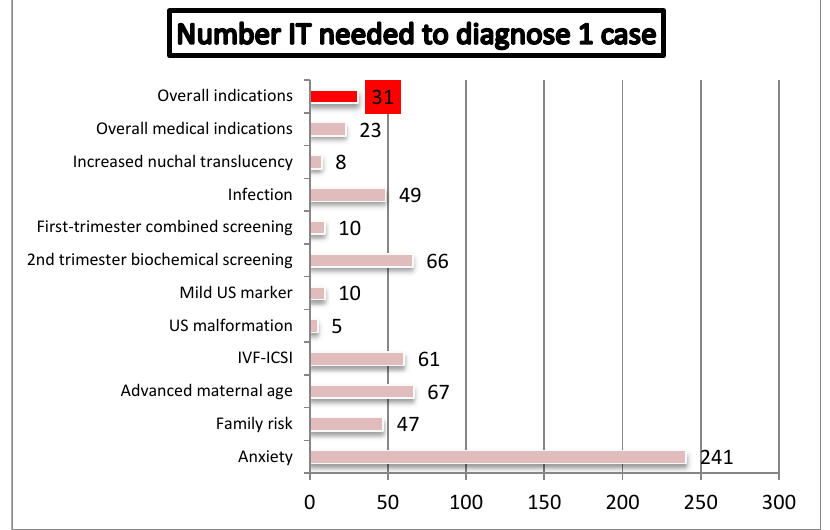
Figure 9. Number of invasive tests needed to diagnose one relevant chromosome abnormality (IVF-ICSI: In Vitro Fertilization- Intra Cytoplasmic Sperm